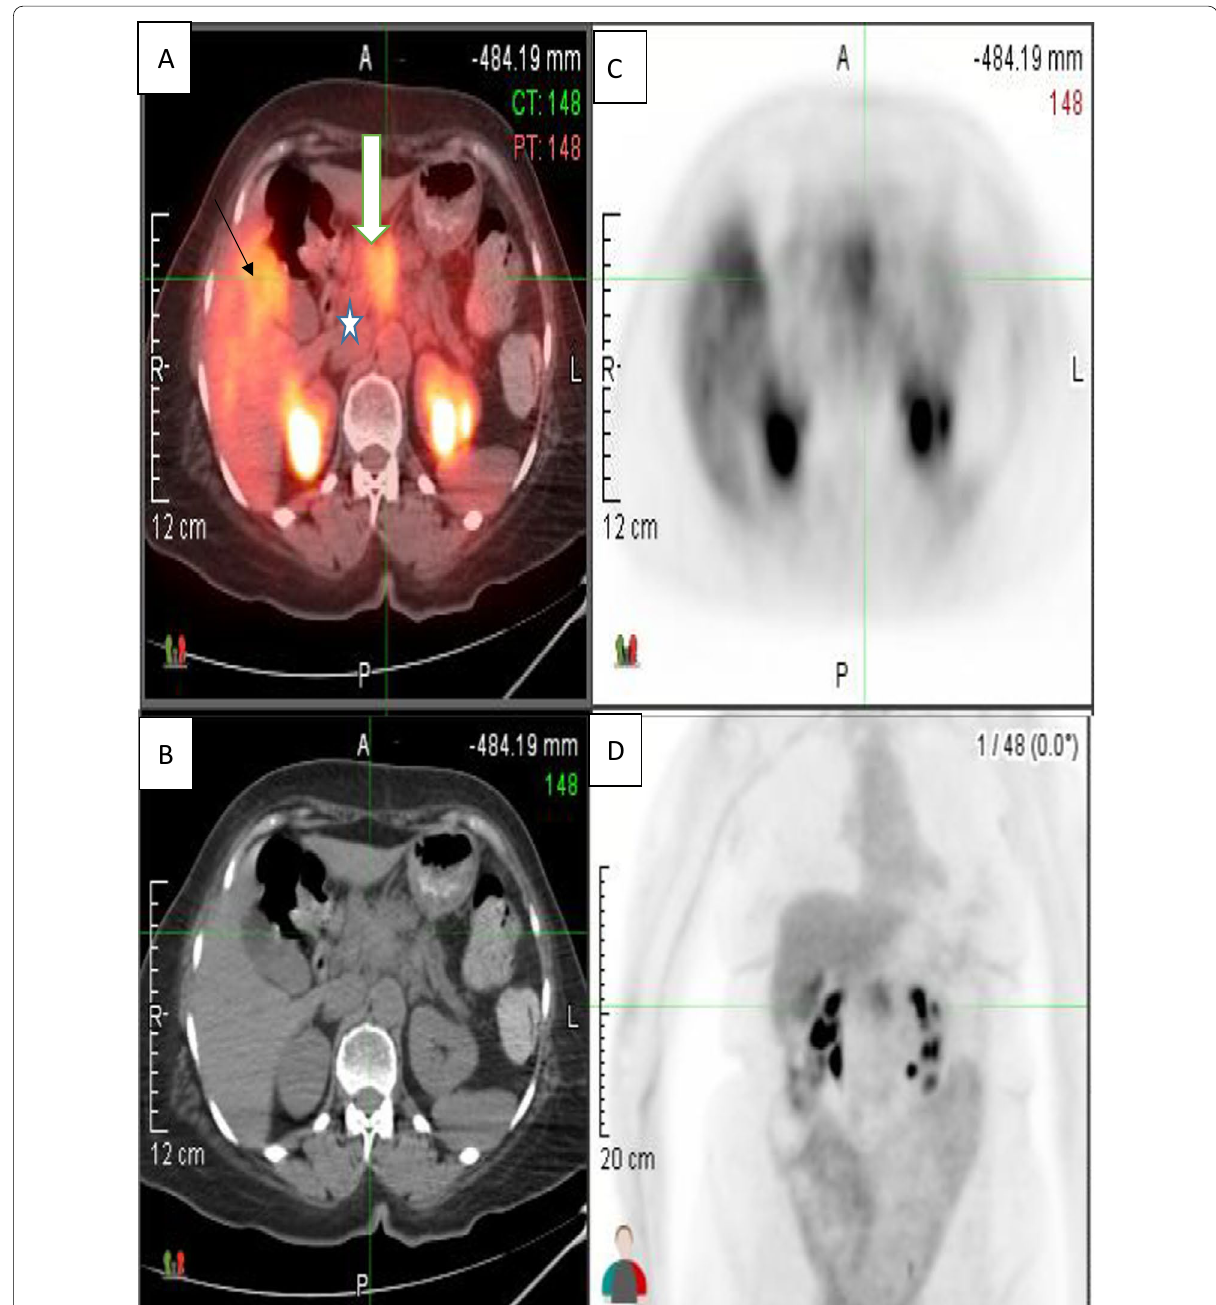
Fig. 2 71-year-old female patient with 3 2.5 cm pancreatic FDG avid mass in the pancreatic neck and proximal body with SUV max 2.9 (white × block arrow) G2 PNET, which is histopathologically proved, producing downstream atrophy of the pancreatic body with dilatation of the pancreatic duct (star). Medial segment of the left liver lobe near the gall bladder fossa shows metastatic lesion measuring 5 arrow). Physiologic uptake in the urinary tract is noted. A Fused Axial PET/CT, B Axial CT, C , D